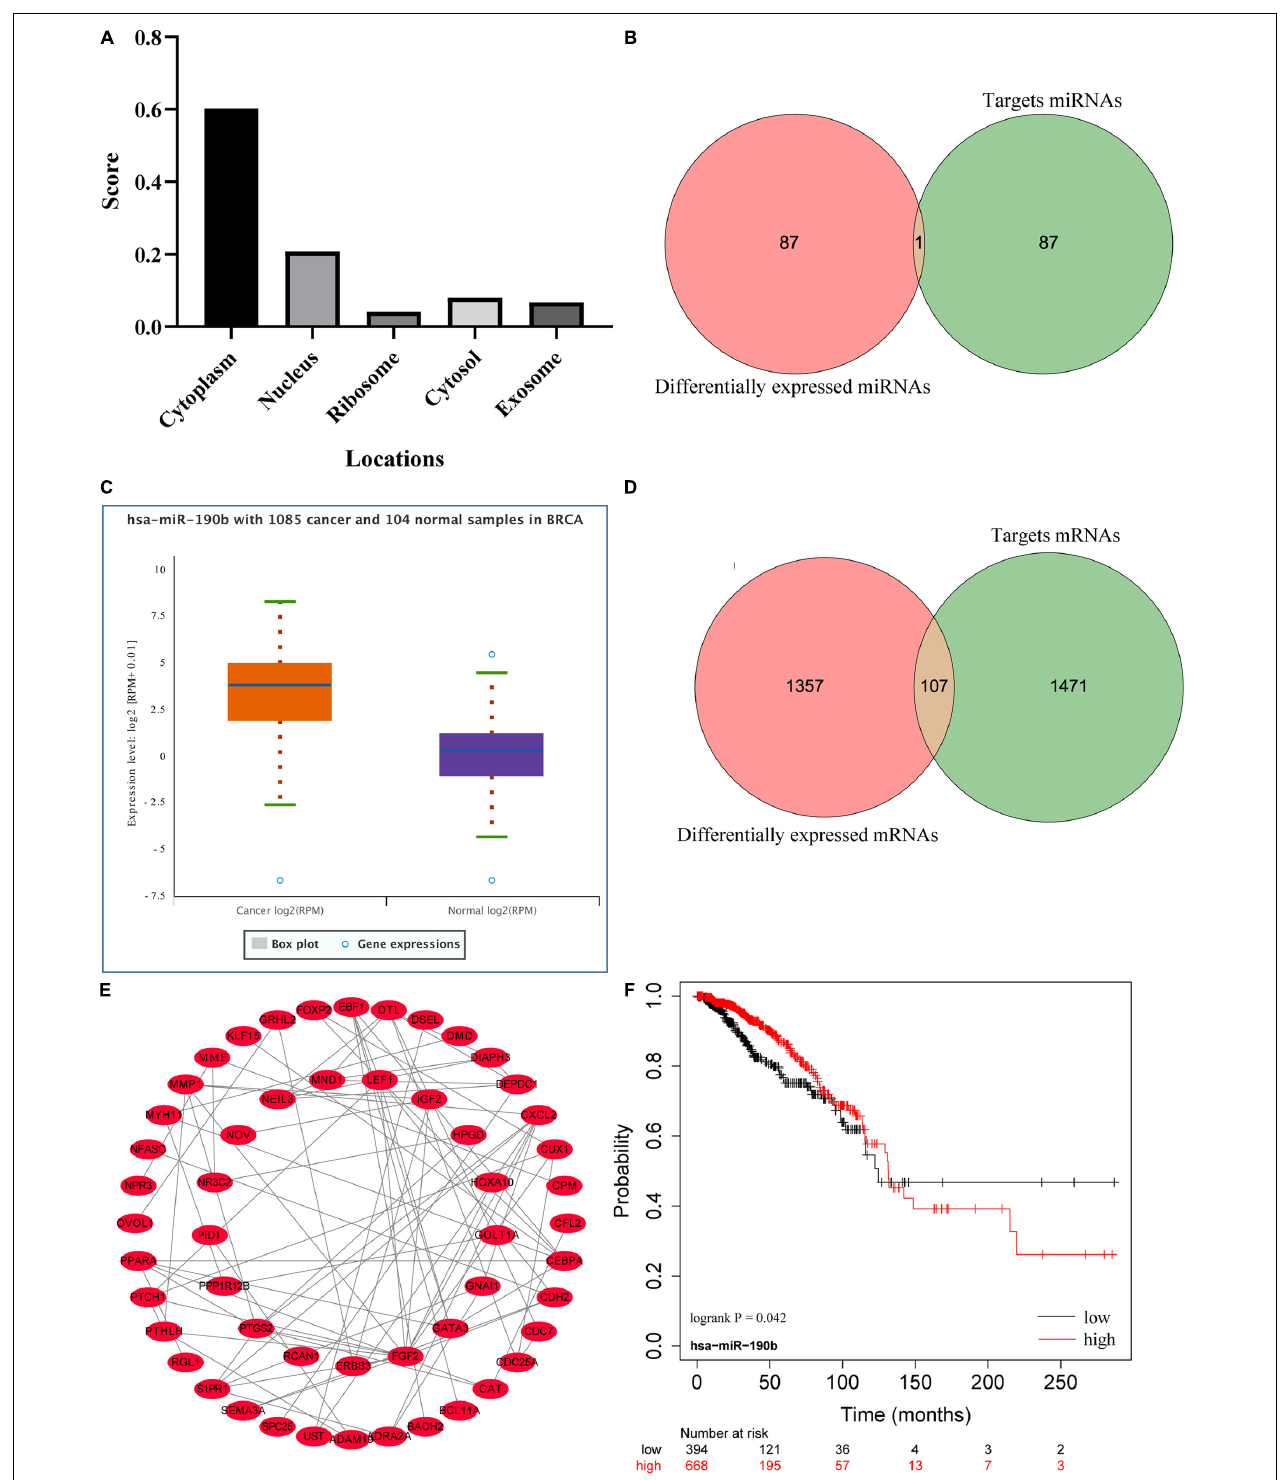
FIGURE 4 | (A) Subcellular localizations of LINC01235 and FGF14-AS2 by using lncLocator (http://www.csbio.sjtu.edu.cn/bioinf/lncLocator/). (B) Venn diagram shows the overlapping miRNAs of LINC01235 targeting miRNAs and differentially expressed miRNAs. (C) The box plot shows the expression trend of miR-190b in TCGA breast cancer using Starbase (http://starbase.sysu.edu.cn/). (D) Venn diagram shows the overlapping mRNAs of miR-190b targeting mRNAs and differentially expressed mRNAs. (E) Protein–protein interaction (PPI) network of the hub genes. The regulatory relationship of hub genes was visualized using Cytoscape. (F) Kaplan–Meier analysis results of miR-190b in breast